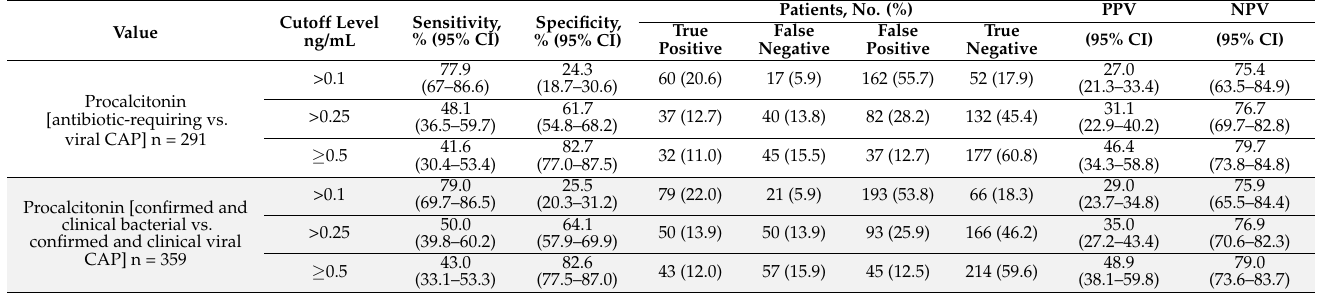
Table 3. Cutoff levels, sensitivity and specificity for procalcitonin in detecting bacterial pneumonia.